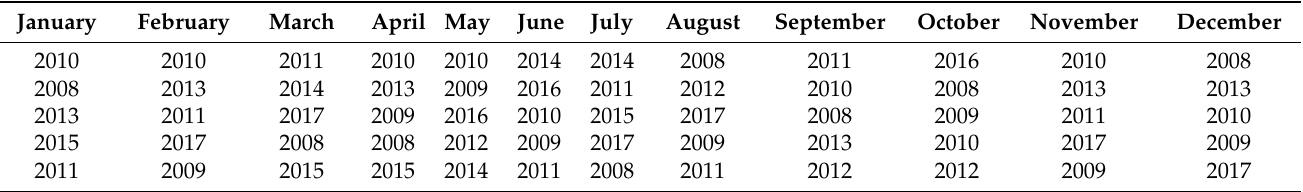
Table 5. Summary of the 5 years selected candidates for each of the MMT (Santiago EOAS station).